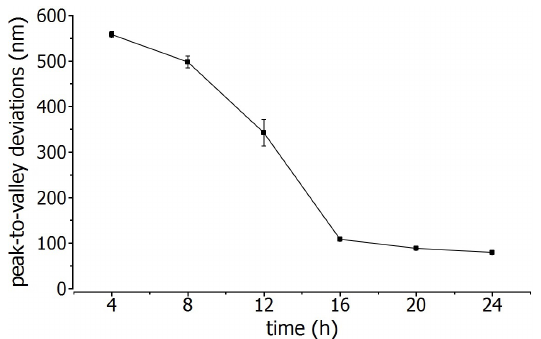
Figure 9. Peak-to-valley deviations as a function of polishing time for the workpiece